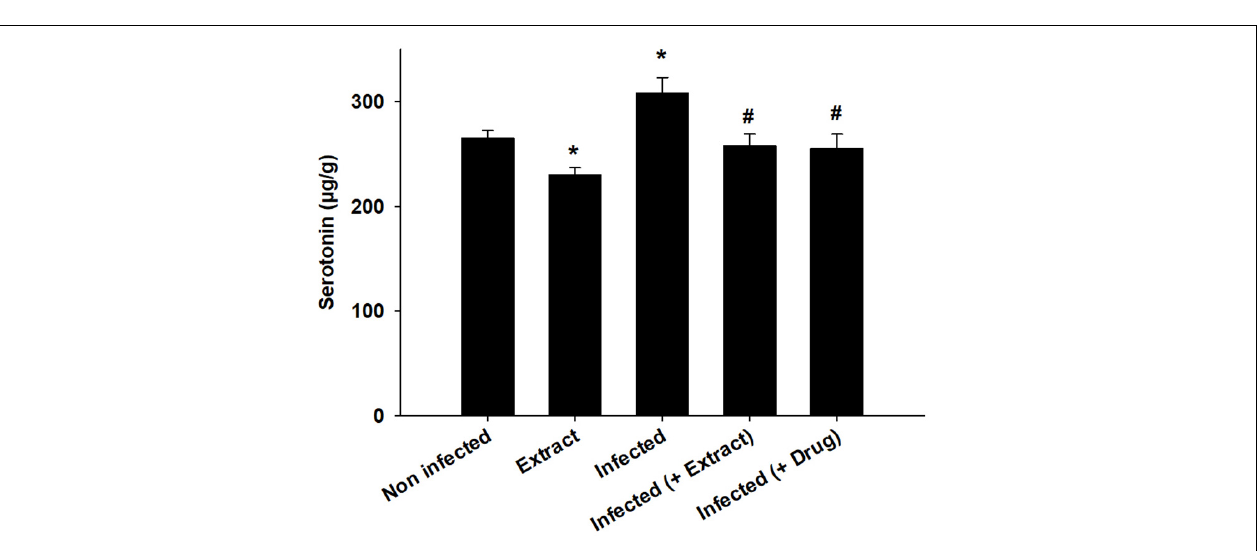
FIGURE 6 | E. camaldulensis induced change in the level of Serotonin of mice infected with T. evansi . *, significance against control group at p ≤ 0.01. # , significance against infected group at p ≤ 0.01.